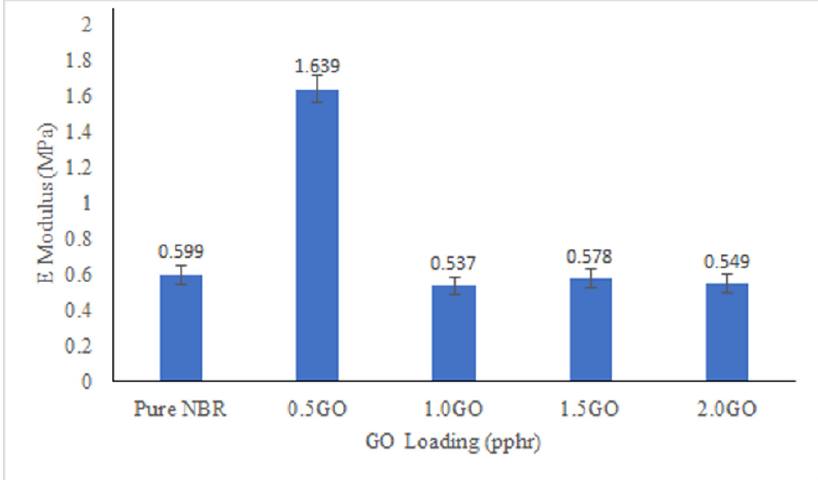
Figure 5. E-modulus of the membranes at different GO loading.